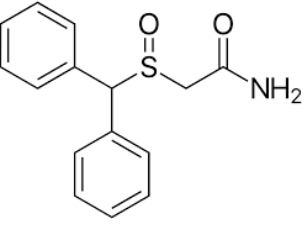
Figure 29. Chemical structure of modafinil. Formula: C 15 H 15 NO 2 S.